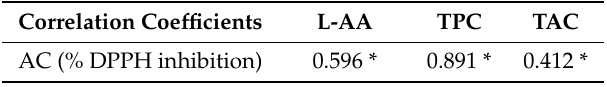
Table 6. Correlation coefficients ( r 2 ) between antioxidant capacities (% DPPH inhibition), total phenolic, total anthocyanin, and ascorbic acid contents in the mulberry